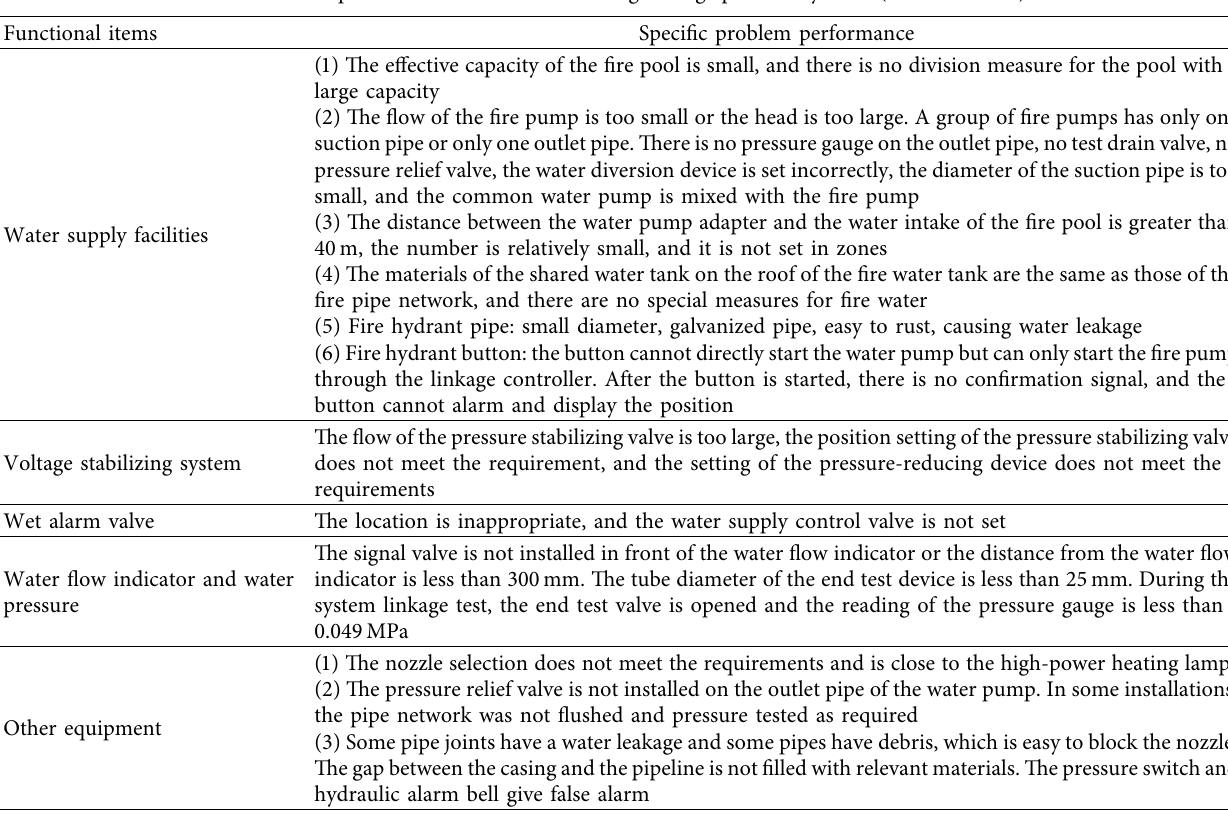
Table 8: Te problem of automatic fre-extinguishing sprinkler systems (source: author). Functional